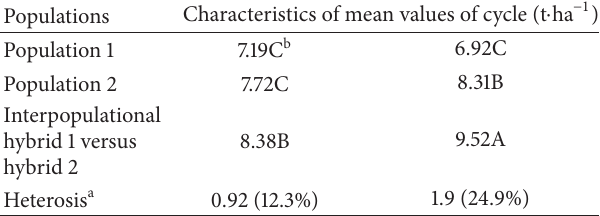
Table 4: Heterosis and the direct response to reciprocal recurrent selection(RRS)inmaizeintheinterpopulationalhybriddetermined on the basis of mean yield (unhusked ear weight t ⋅ ha − 1